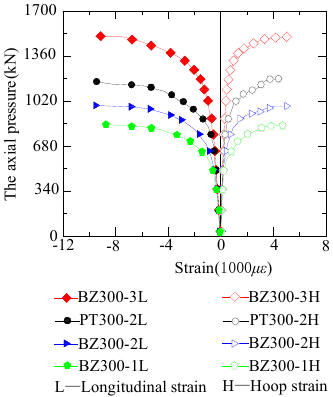
Figure 6. λ = 2.6 load–strain relationship.